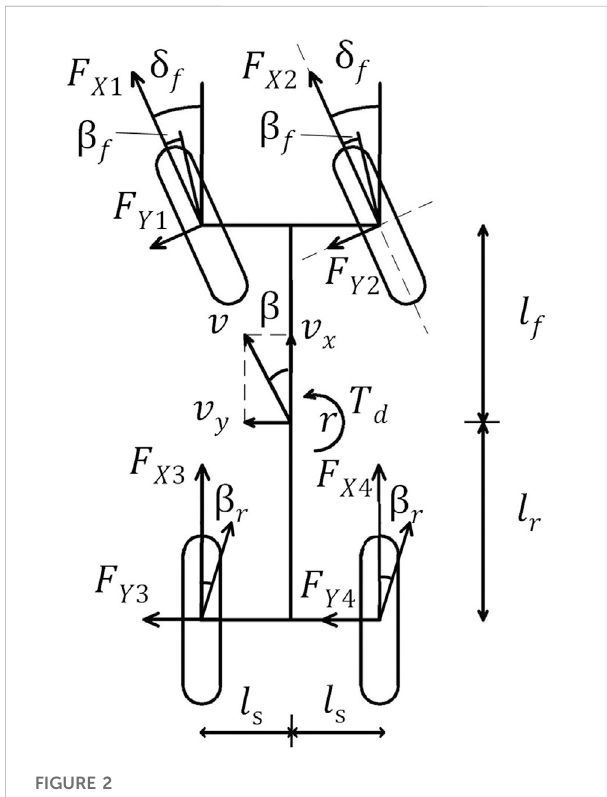
FIGURE 2 3-DOF vehicle dynamics